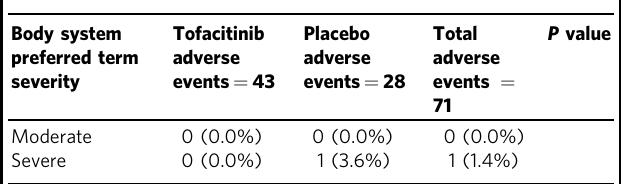
Table 2 Adverse event frequency and